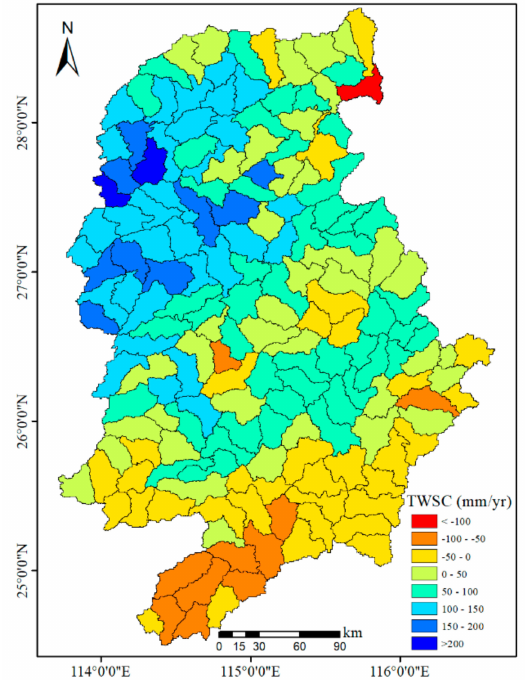
Figure 8. Spatial distribution of multi-year average (2002–2018) TWSC in the Ganjiang River